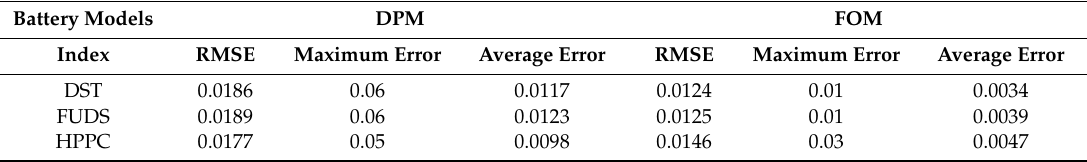
Table 11. SOC estimation errors using di ff erent models under di ff erent test